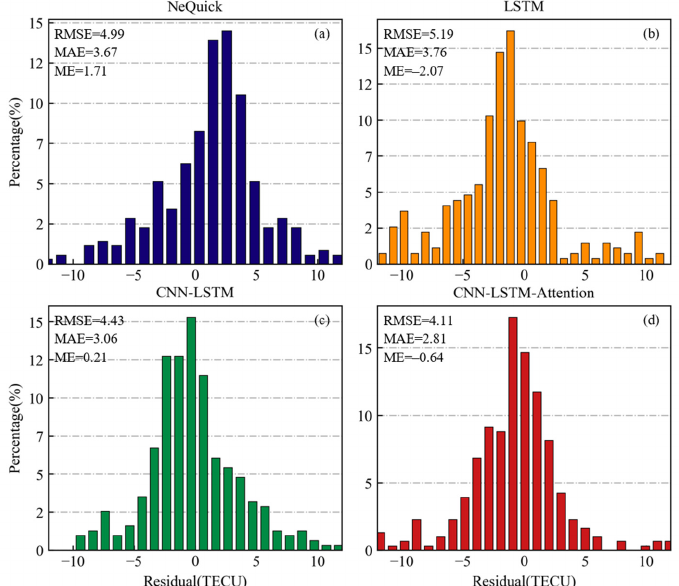
Figure 14. Residual distribution of different models for GDZH station during magnetic storm period. RMSE, MAE, and ME are also included. ( a ) NeQuick; ( b ) LSTM; ( c ) CNN-LSTM; ( d ) CNN-LSTM-Attention model.